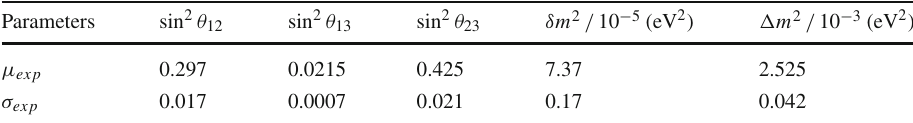
Table 1 Neutrino data used in the sampling of the μν SSM